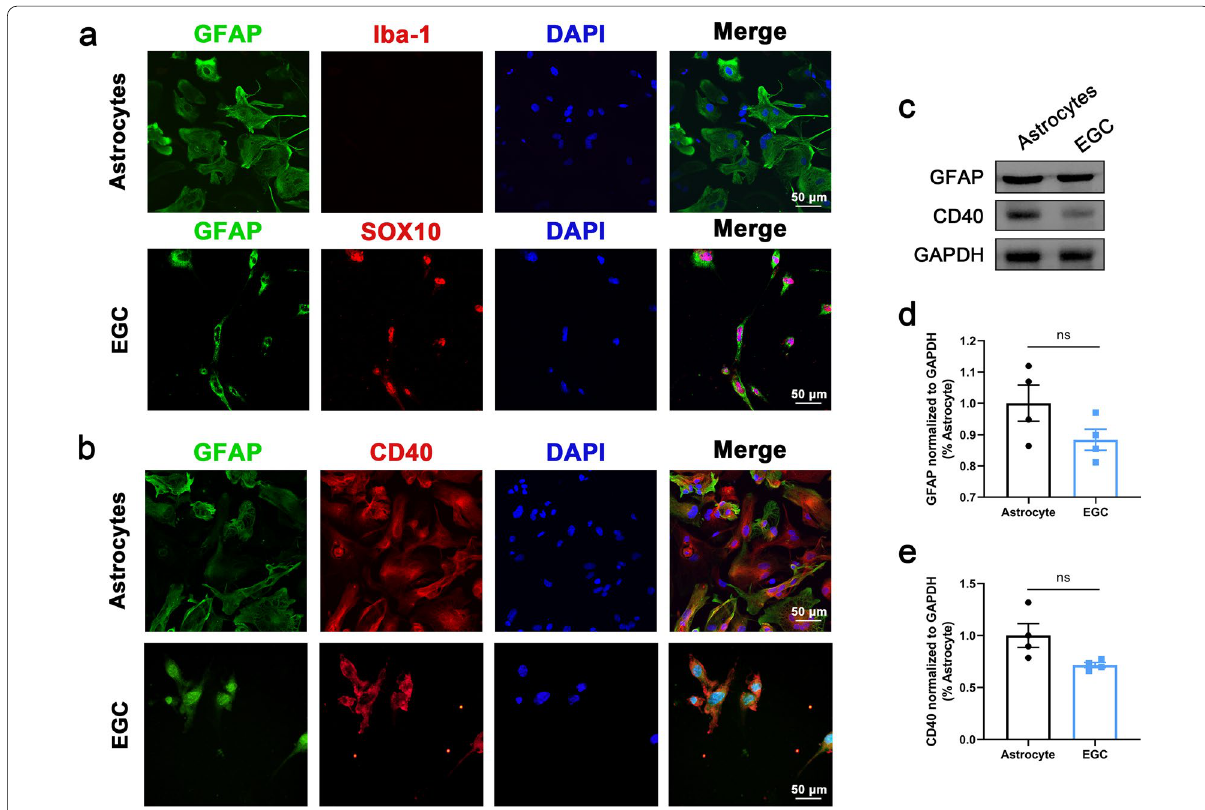
Fig. 3 Localization of CD40 in EGCs. a The purity of primary EGCs and astrocytes cultures was > 95% as determined by immunofluorescence. b GFAP and CD40 immunofluorescence was detected in primary EGCs and astrocytes. c – e Western blot analysis showed that CD40 was expressed in primary EGCs as in